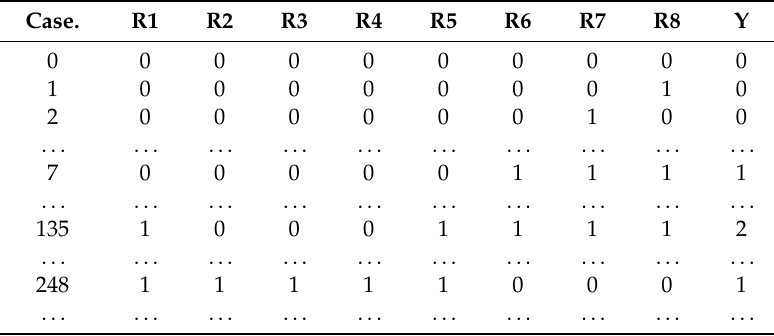
Table 3. Accuracy Table for DSP and LR.